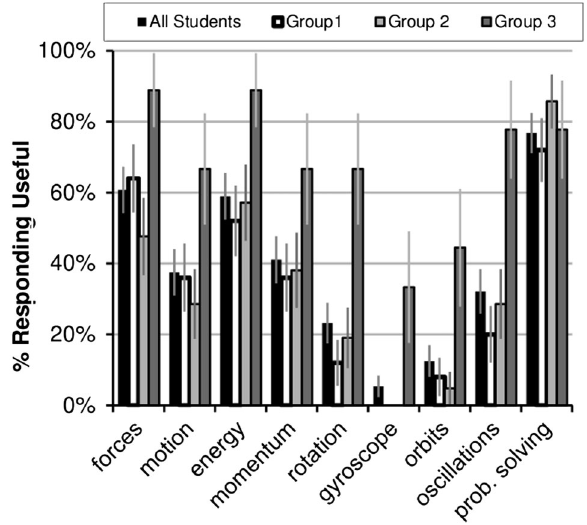
FIG. 9. Frequency with which various topics taught in me- chanics were circled as ‘‘useful to you since taking [mechanics]’’ by students on the demographic survey.